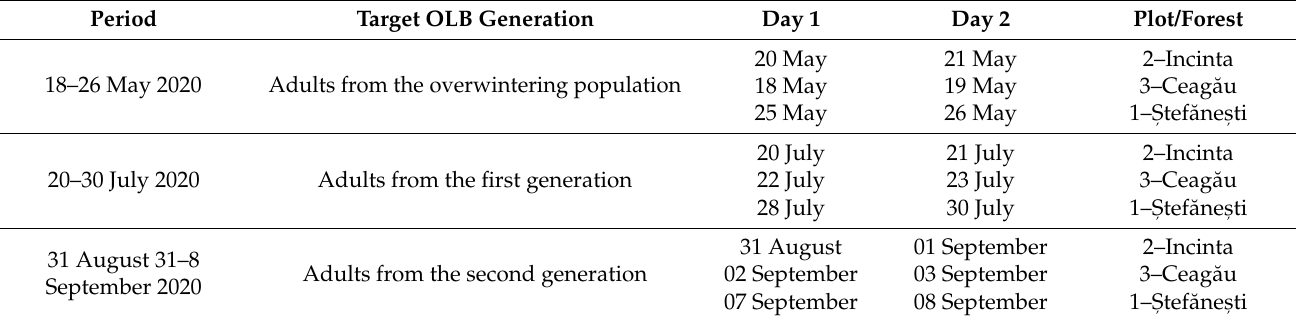
Table 3. Periods during which monitoring was performed in the three studied